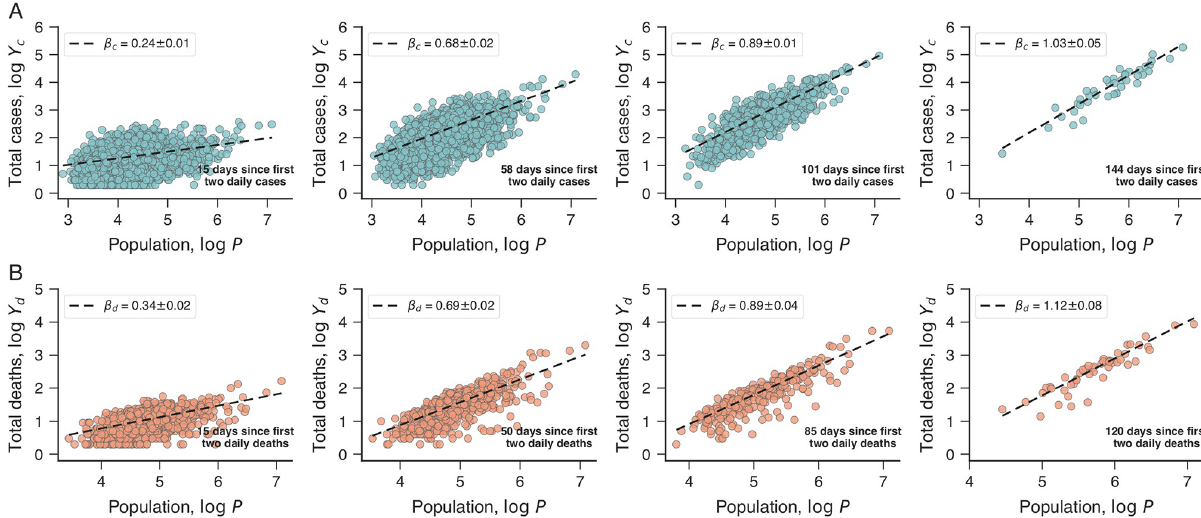
Fig 1. Urban scaling relations of COVID-19 cases and deaths. (A) Relationship between the total of confirmed cases of COVID-19 ( Y population ( P ) on logarithmic scale. Panels show scaling relations for the number of cases on a particular day after the first two daily cases reported in each city (four evenly spaced values of t between 15 days and the largest value yielding at least 50 cities, as indicated within panels). (B) Relationship c between the total of deaths caused by COVID-19 ( Y d ) and population ( P ) of Brazilian cities (on logarithmic scale). Panels show scaling relations for the number of deaths on a particular day after the first two daily deaths reported in each city (four evenly spaced values of t value yielding at least 50 cities, as indicated within panels). In all panels, the markers represent cities and the dashed lines are the adjusted scaling relations with best-fitting exponents indicated in each plot ( β c for cases and β d for